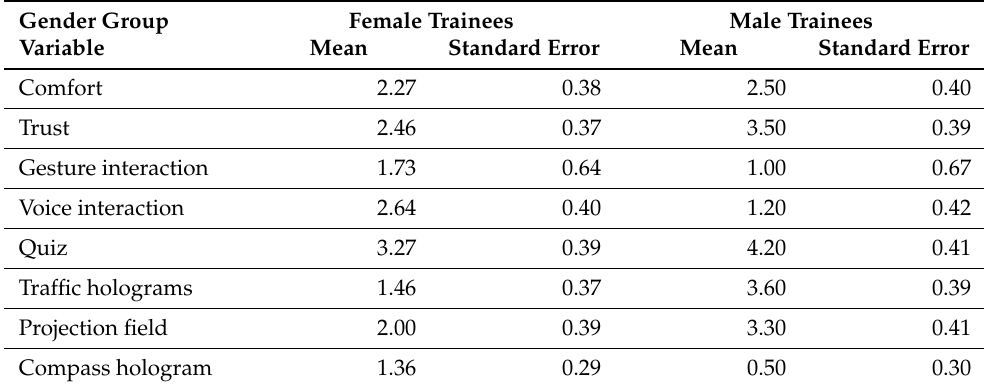
Figure 5. Mean scores of the ARI subscales in female and male trainees from the experimental group that used the AR applications. Error bars represent standard errors. Table 4. Appreciation of various features of the AR applications in female and male